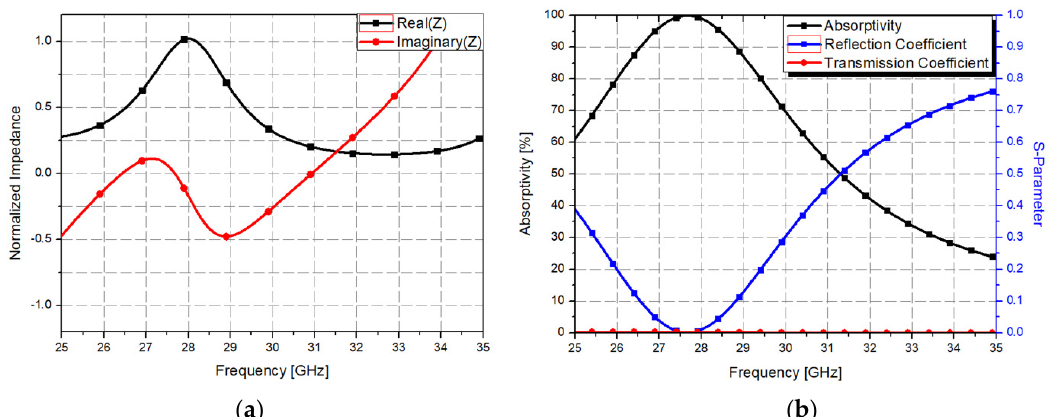
Figure 3. ( a ) Normalized impedance and ( b ) simulated S-parameters and absorptivity plotted against frequency.